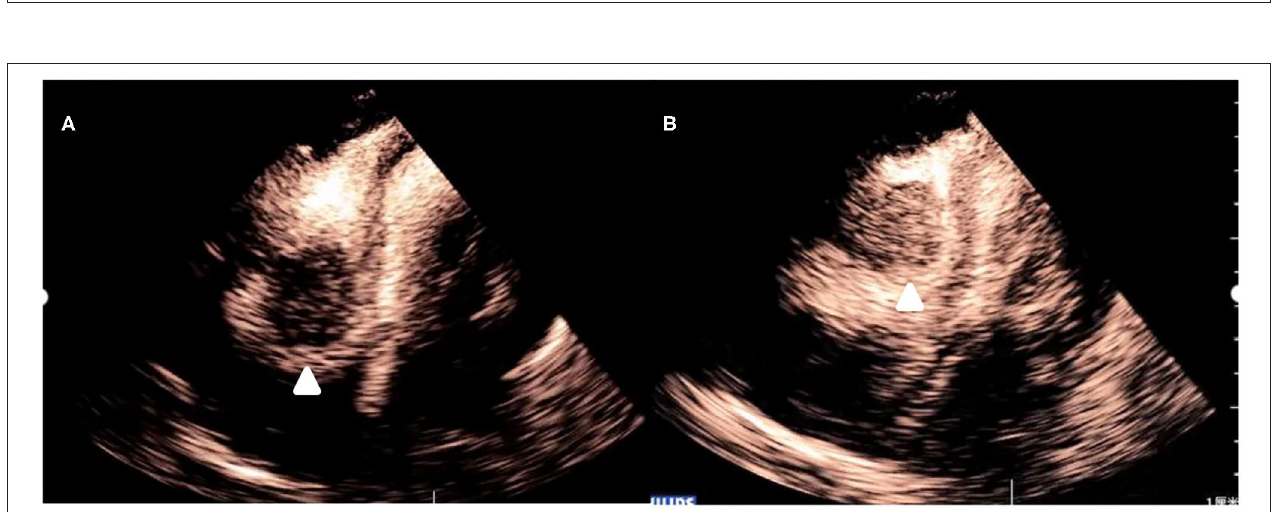
FIGURE 2 | Myocardial contrast echocardiography images of the mass. (A) After administration of the contrast agent, there is partial enhancement of the mass. (B) After several cardiac cycles, there is an increase in enhancement of the mass.